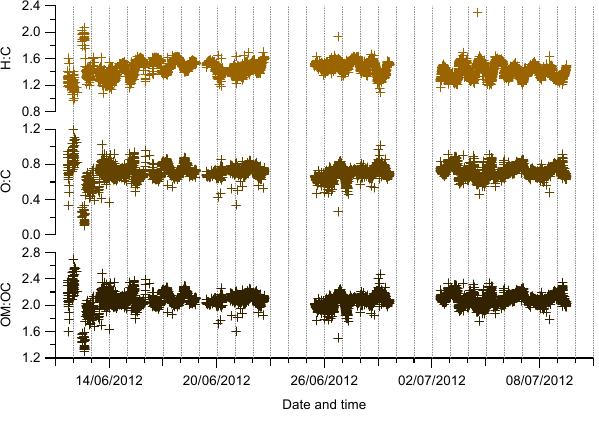
Figure 2. Time series of the H:C, O:C and OM:OC ratios. Time is local (UTC +